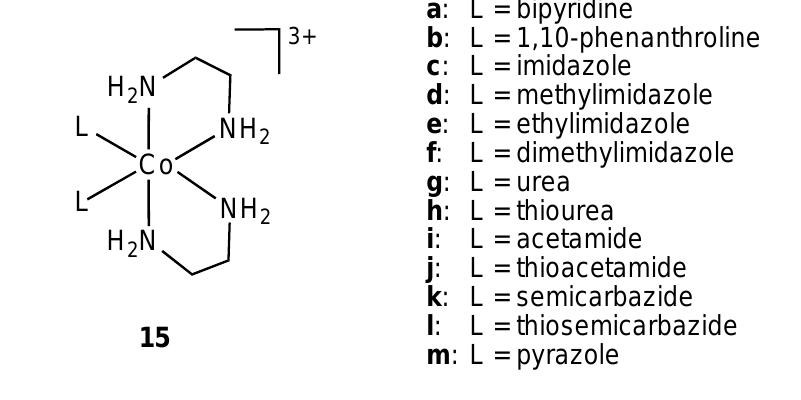
Figure 9. Ethylenediamine cobalt(III) cations 15 (bipyridine and 1,10-phenanthroline ligands are coordinated in bidentate chelating mode to the metal